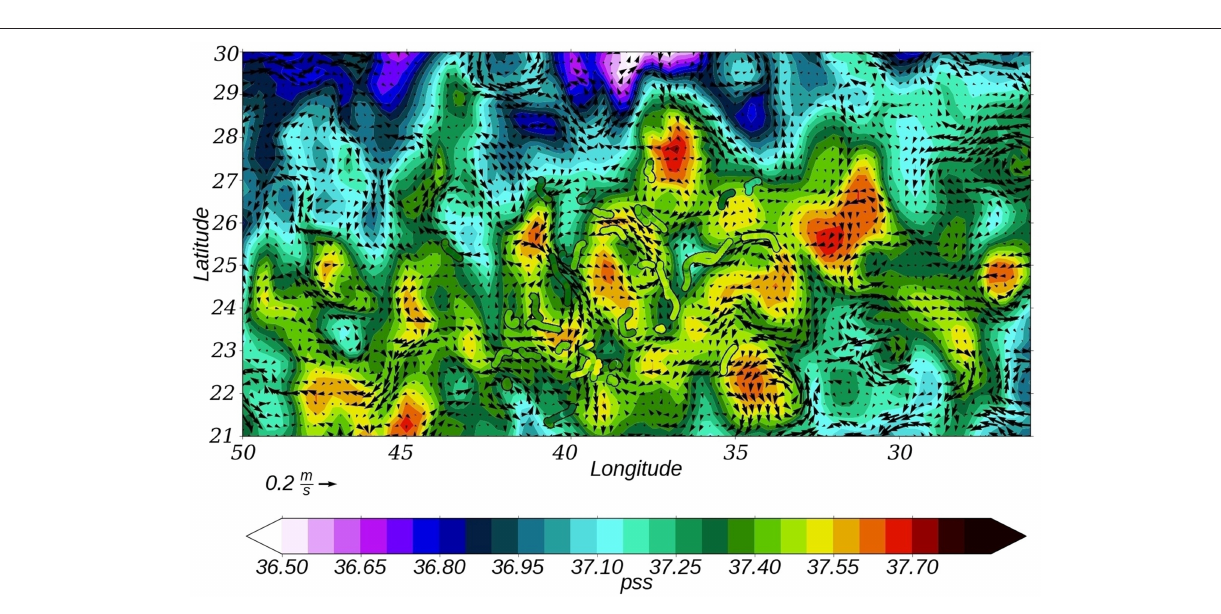
FIGURE 3 | SMOS SSS vs. SPURS drifters and AVISO geostrophic velocity field, 8–14 January